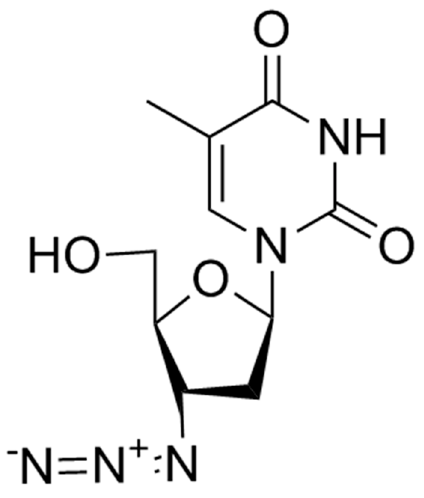
Figure 1. Zidovudine. Figure 1.